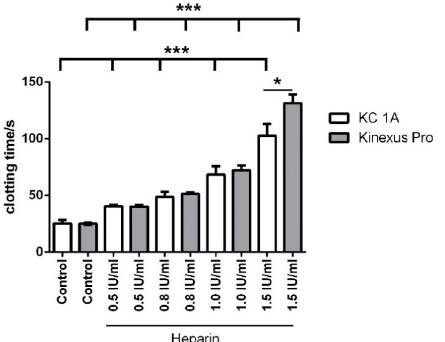
Figure A3. Clotting time (CT) of citrated blood with various heparin concentrations activated with Thromborel measured with Kinexus Pro (grey) or KC 1A (white). The asterics above the bars indicate that this particular bar is significantly different from all others. Apart from the higher heparin concentration (1.5 IU/mL; * p < 0.05) there was no significant difference between CT measured with both devices. The addition of heparin led to significant increases in CT values (*** p < 0.001) for each concentration and in both devices.